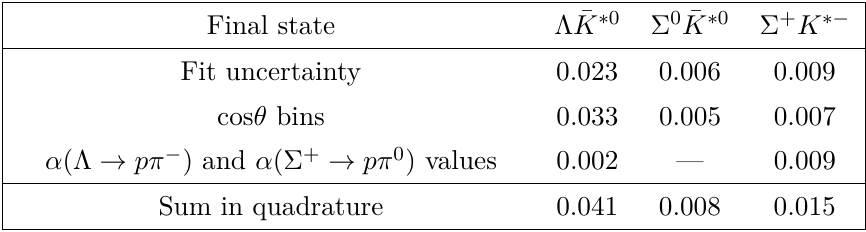
Table 8 . Absolute systematic uncertainties in the asymmetry parameter extractions. of Ξ 0 , and no systematic error has been included from this source [48]. Finally, the ab- c solute systematical uncertainties for α (Ξ 0 α (Ξ 0 → Σ + K ∗− ) are estimated by adding all individual uncertainties in quadrature. All c the uncertainties are summarized in table